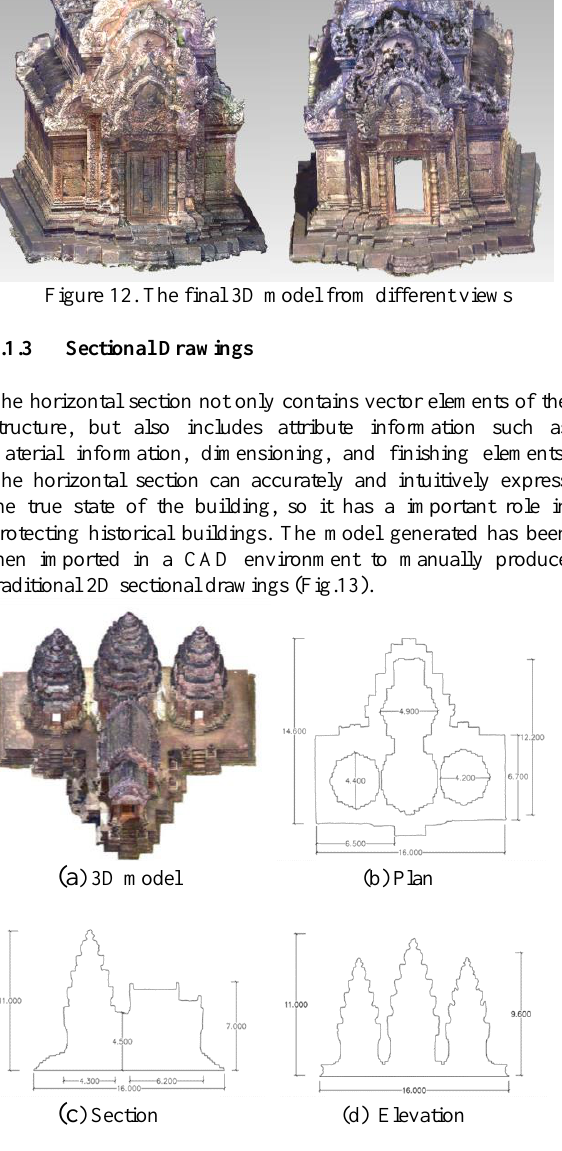
Figure 13. The 3D model of Banteay Seri and plan, section and